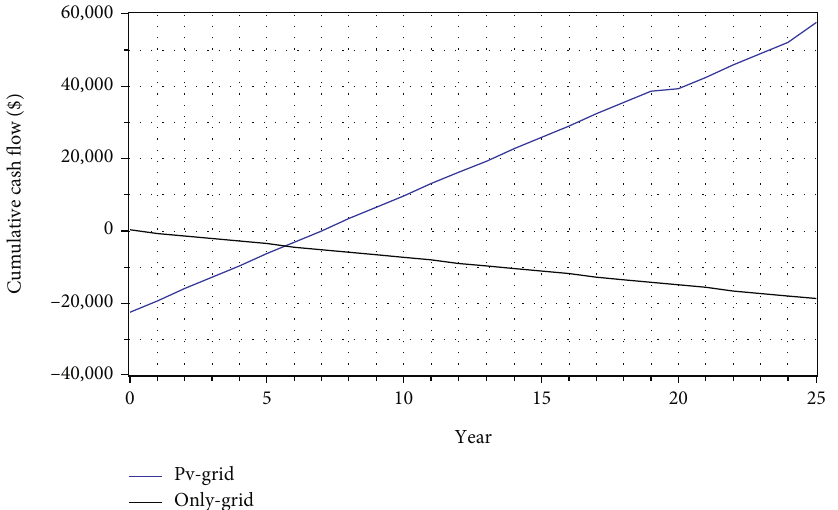
Figure 7: Economic comparison of PV-grid system with an only-grid system in 25 years lifetime of the project.